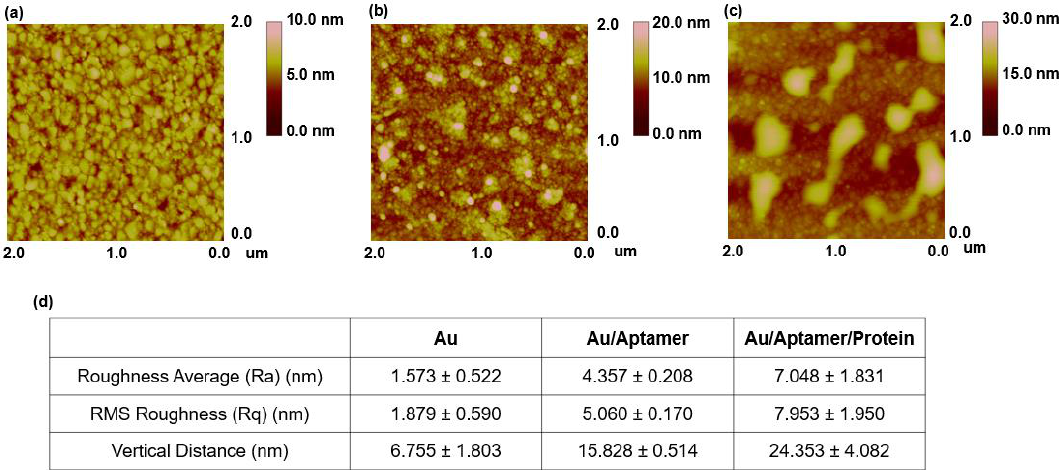
Figure 3. ( a ) AFM image of the bare substrate. ( b ) AFM image of the aptamer on the Au substrate. ( c ) AFM image of the aptamer and Zika envelope conjugate on the Au substrate. ( d ) Surface analysis of the Au substrate, Au/aptamer substrate, and Zika envelope conjugate using roughness average, RMS, and vertical distance.